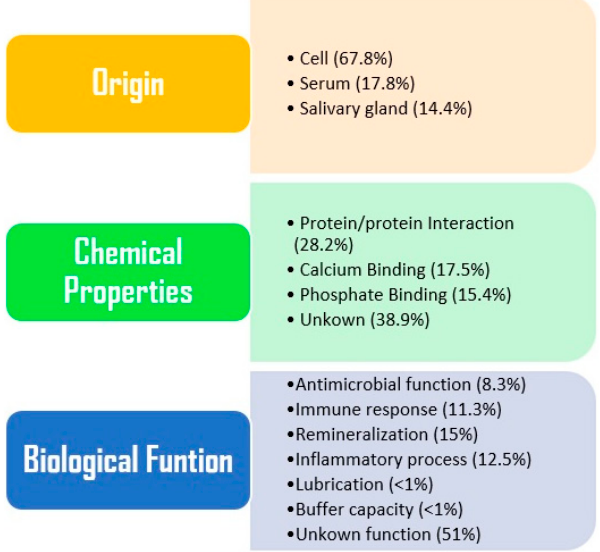
Figure 3. Classification of acquired enamel pellicle (AEP) proteins according to their origin,